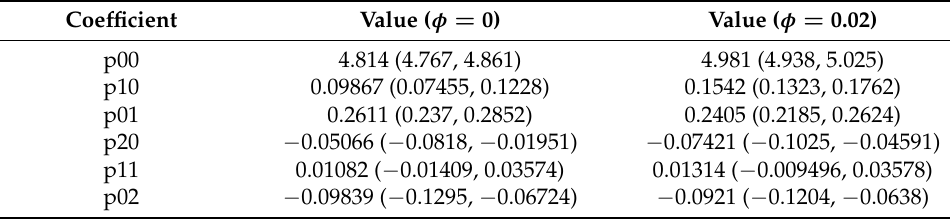
Table 4. Coefficients (with 95% confidence bounds).